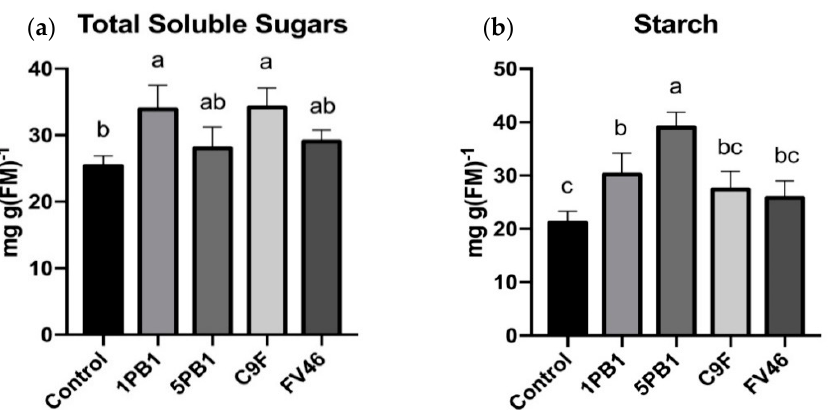
Figure 2. Effect of inoculation with isolates 1PB1, 5PB1, C9F and FV46 on Total Soluble Sugar ( a ) and Starch ( b ) contents, of tomato leaves of 130-day-old plants. Presented values are means ± SD (n = 3) of measurements on each treatment group. Means with the same letter are not significantly different according to the Dunnett test ( p < 0.05).